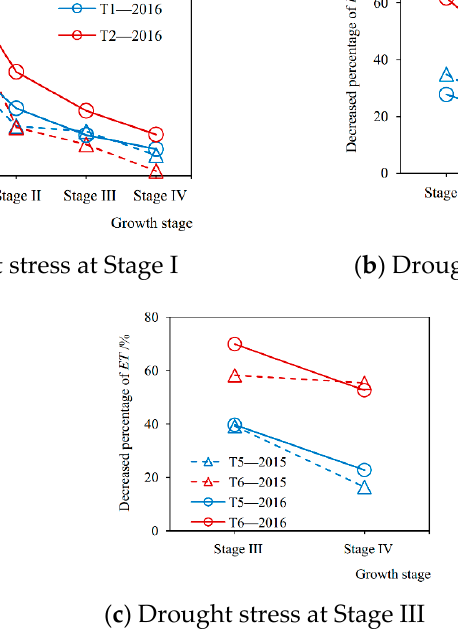
Figure 4. The decreased percentages of soybean evapotranspiration ( ET ) during each growth stage caused by drought stress at ( a ) Stage I, ( b ) Stage II, and ( c ) Stage III, respectively, compared with full irrigation in 2015 and 2016 seasons. Stage I: seedling stage, Stage II: branching stage, Stage III: flowering-podding stage, Stage IV: seed filling stage. T1–T6: experimental treatments.